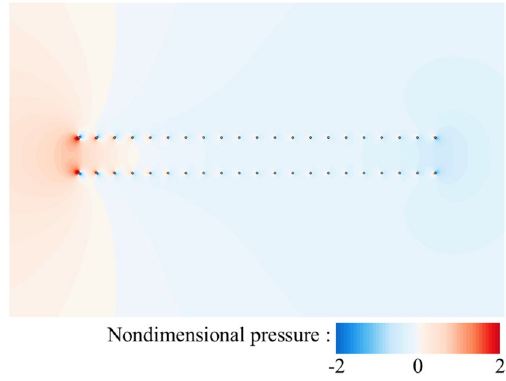
Figure 15. Pressure contour plots of two bristled wings.